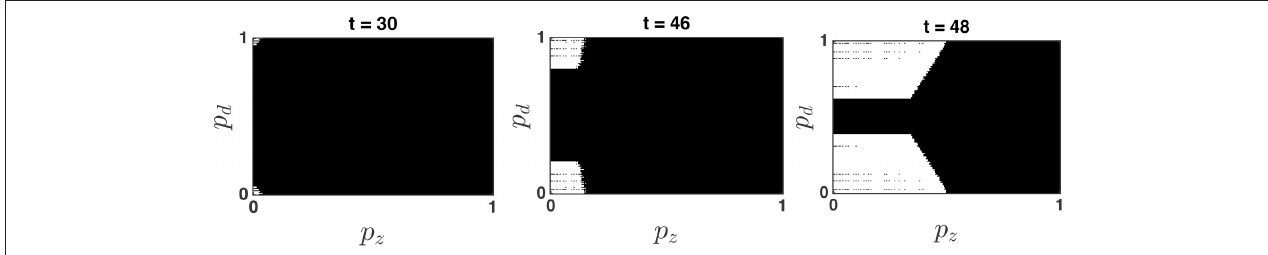
FIGURE 3 | Dynamic evolution of the optimal policy map. The white and black areas denote the Go and Wait regions, respectively. Note that p z denotes the probability that the stop signal has already occurred at time t , and is monotonically related to p s , the probability that the current trial is a stop trial. The Bayesian update algorithm produces a belief state ( p d , p z ) at every time point t based on prior belief and all sensory data x t , y t observed until time t . If the belief state falls into a Go region, a Go response is produced and the trial is terminated; otherwise, at least one more observation is obtained, and the location of the new Bayesian-updated belief state is compared to next time point’s optimal policy map. When/whether the belief state falls into a Go region determines when/whether the subject produces a response on that trial. The simulation shows that the Go regions expand over time, as the response deadline looms closer.